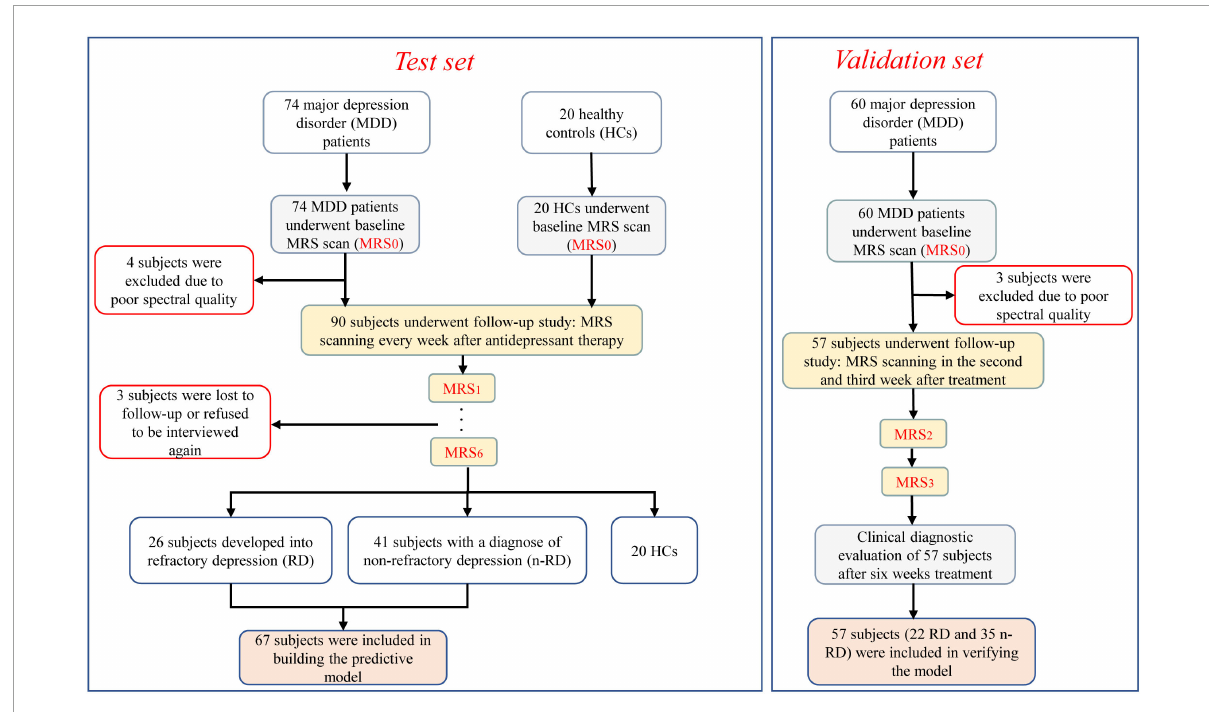
FIGURE1 Flow chart of our study procedure. The boxes with red edge indicate excluded individuals. The light gray boxes indicate the baseline MRI scans. The yellow boxes indicate the procedure for follow-up assessments, and the light orange boxes indicate the subjects included in diagnostic model establishment and